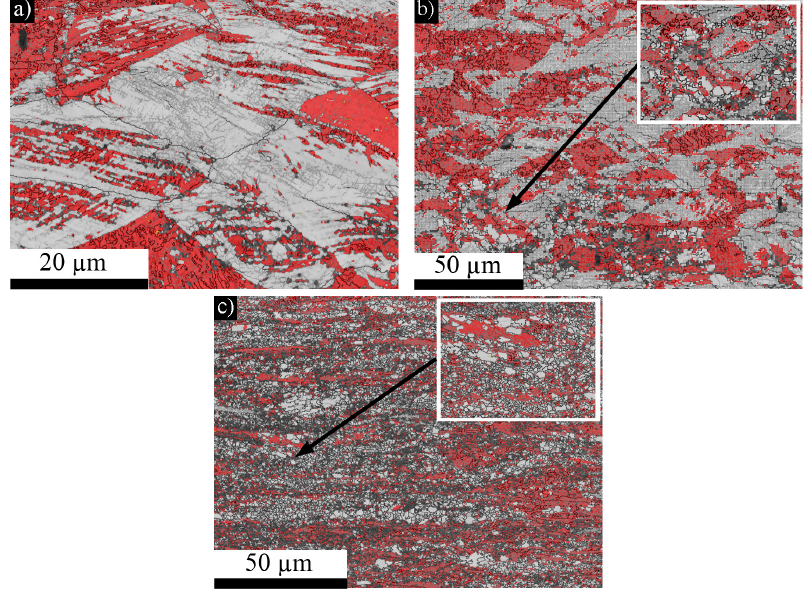
Figure 5. EBSD phase and grain boundary maps of the 32CR ( a , b ) and 63CR ( c ) structures after annealing at 700 °C for 0.1 s. DIM is colored in red; austenite is colored in gray. The inserts display, more clearly, medium-sized grains.